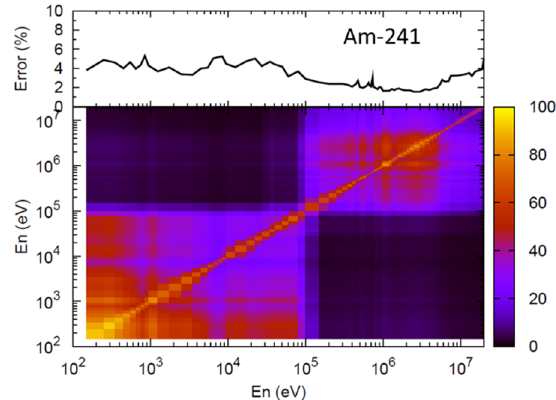
Fig. 3. Uncertainty and correlation of 241 Am fission cross section for fast neutrons